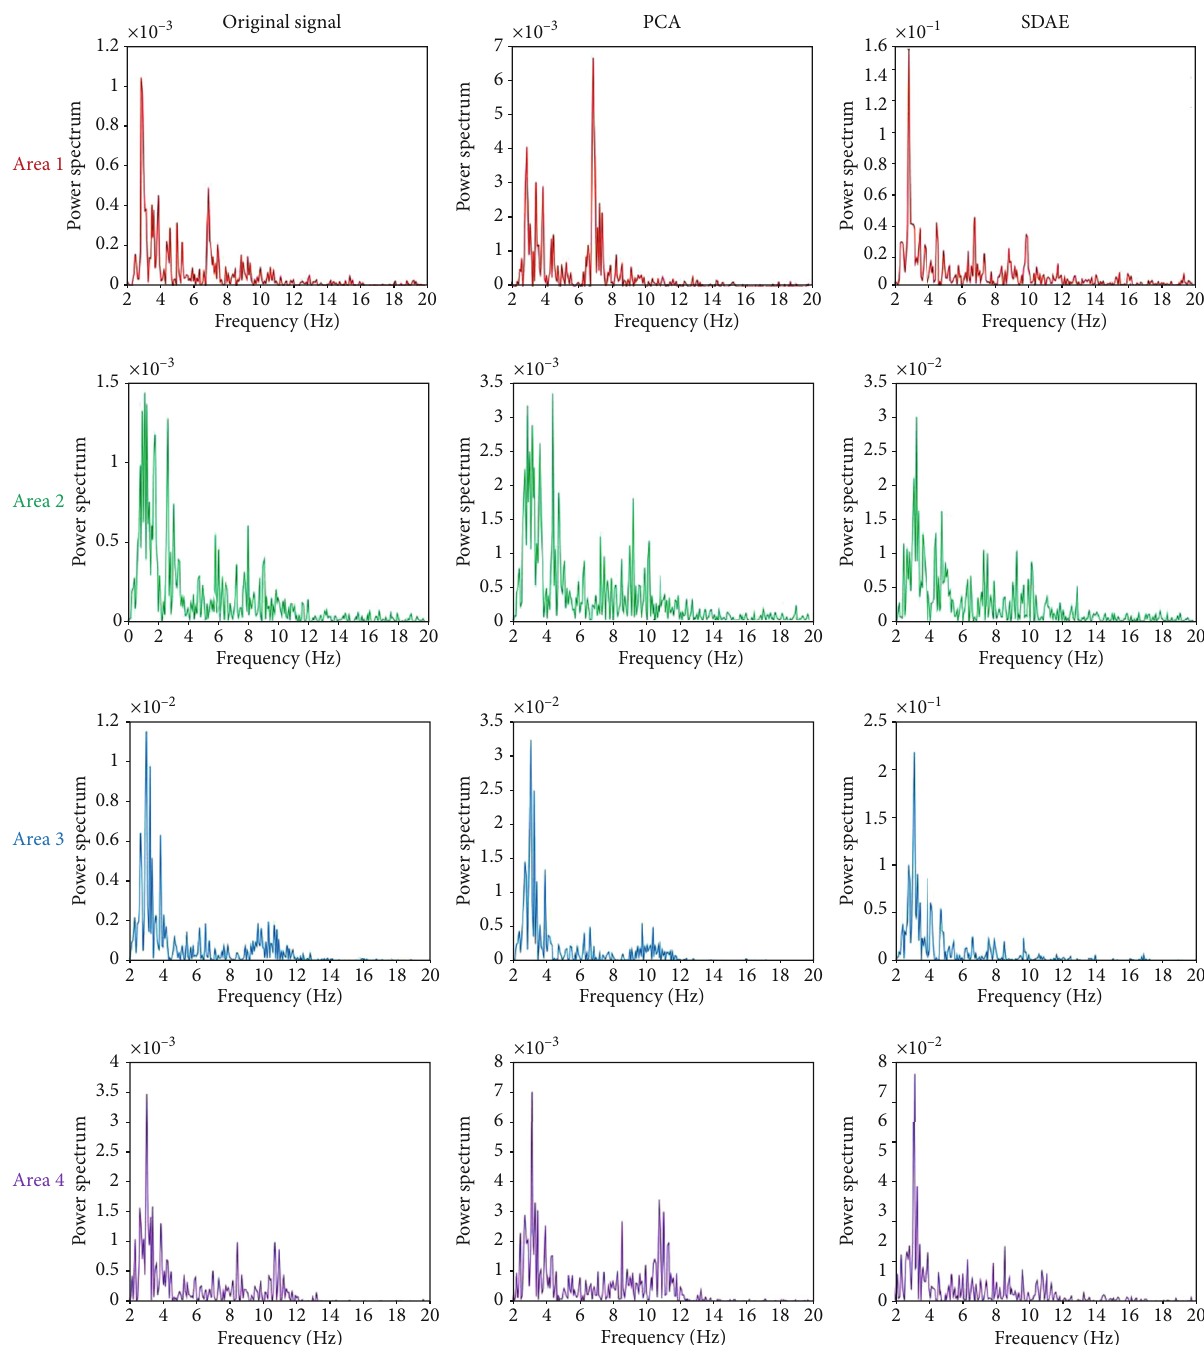
Figure 6: The power spectrum of average original signal, the extracted feature by PCA, and the extracted feature by SDAE from four areas on fatigue